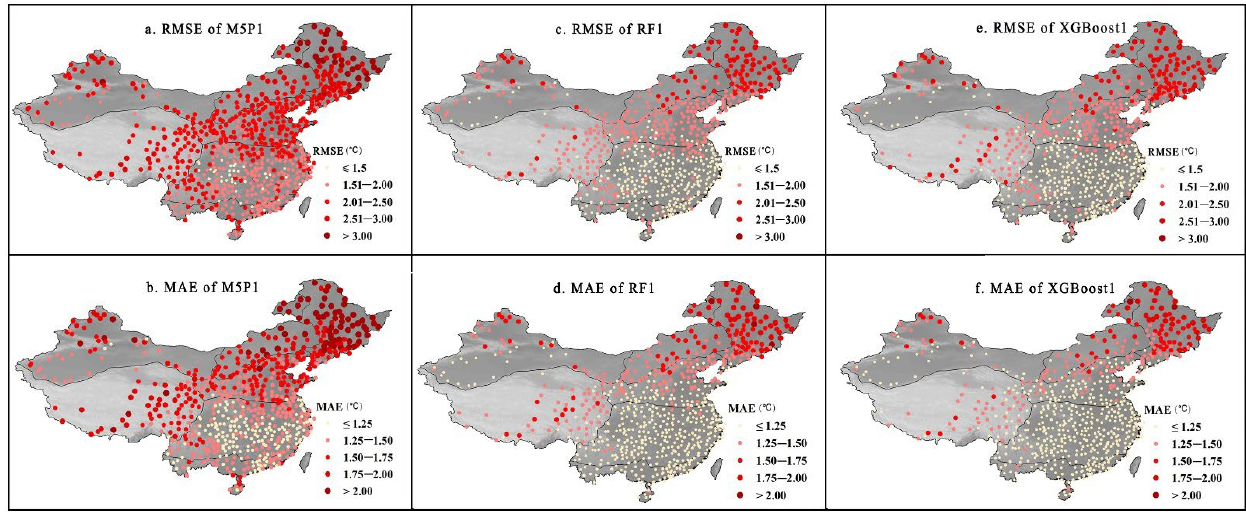
Figure 4. Performance of data-driven models (M5P1: ( a , b ); RF1: ( c , d ); XGBoost1: ( e , f )) for the estimation of T s with T mean , RH, R s , and U 2 as inputs.